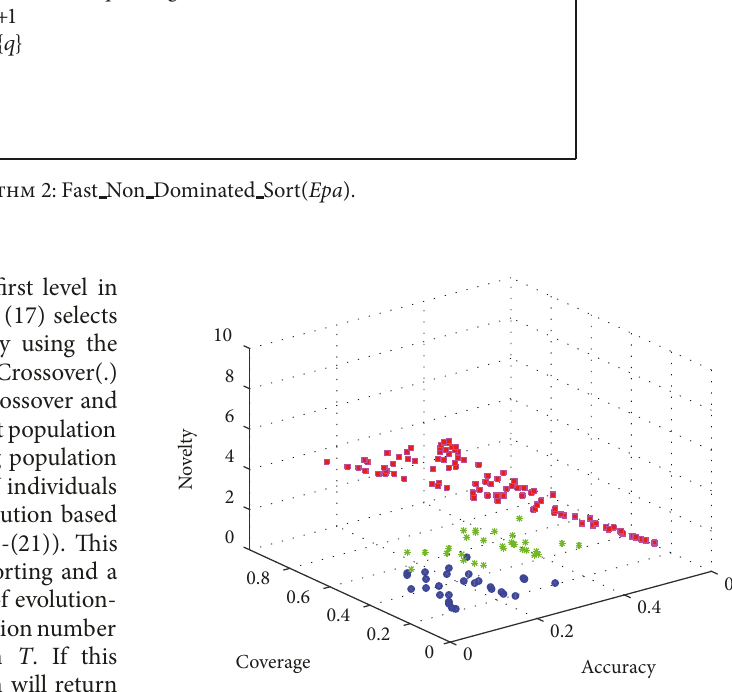
Figure 5: A fast nondominated sorting procedure in NSGA-II re- garding the three objective optimizations